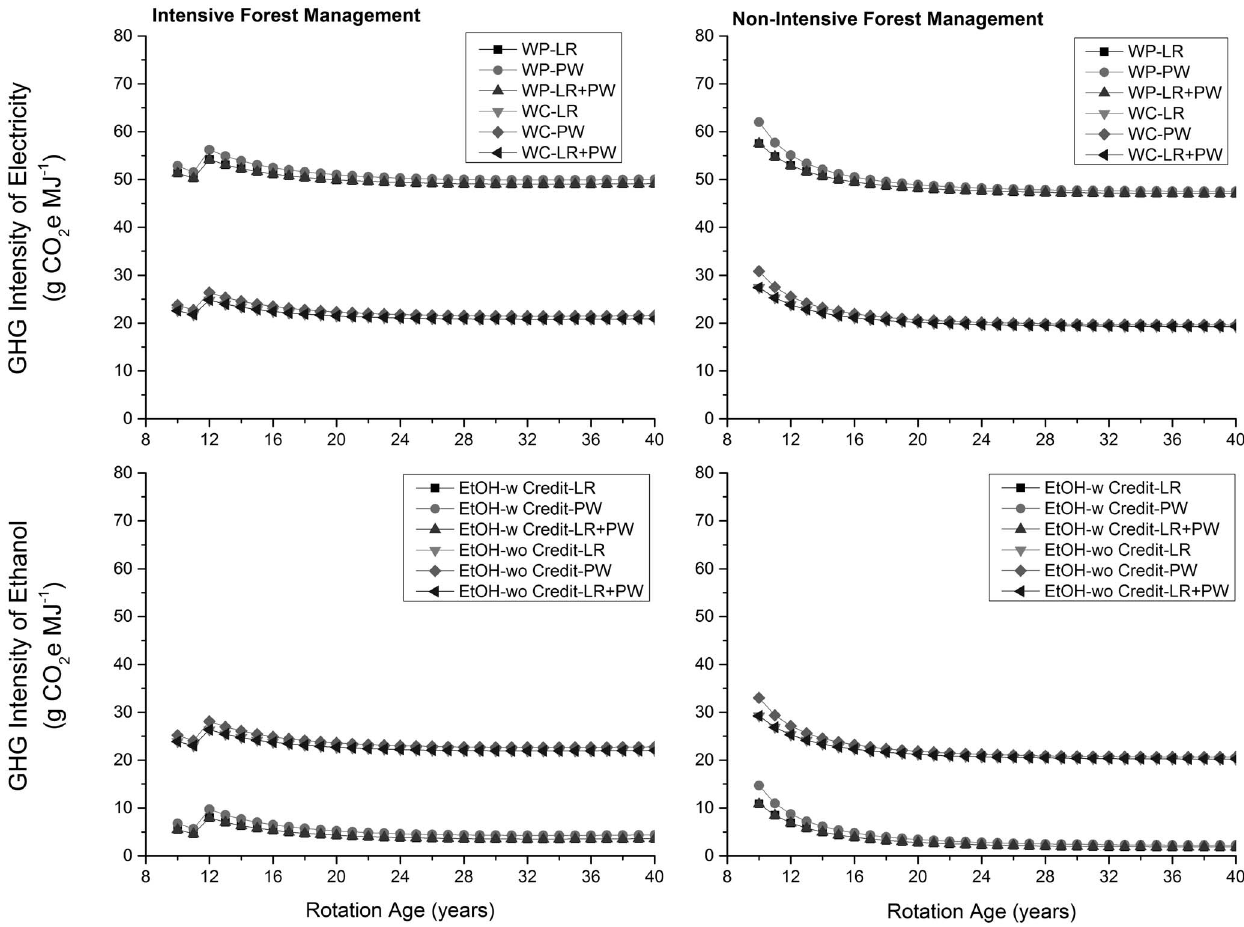
Figure 6. GHG intensity of energy products at the production level. LR: logging residues; PW: pulpwood; WP: wood pellets; WC: wood chips; w: with income from cogenerated electricity; wo: without income from cogenerated electricity.